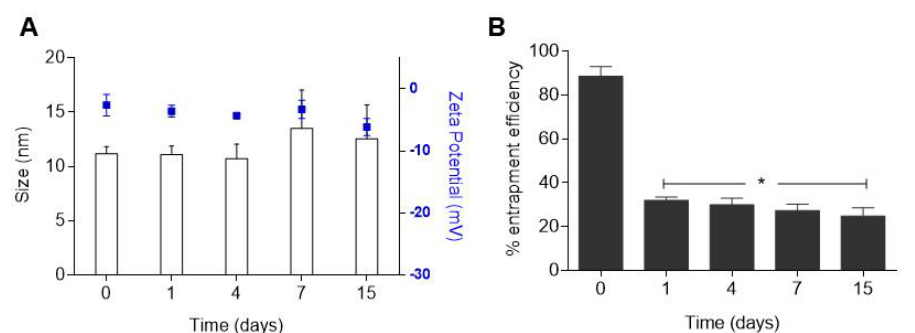
Figure 2. Storage stability of DSPE-PEG IRN micellar formulations stored at 4 ◦ C for 15 days. ( A ) Mean diameter and zeta potential (blue) and ( B ) Entrapment efficiency stability over time. Note: * Represents significant differences ( p < 0.05) compared to day 0. Data are expressed as mean ± SD (n = 3).